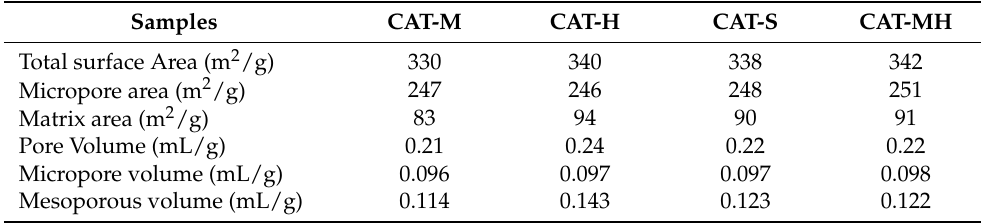
Table 4. Surface structures of the